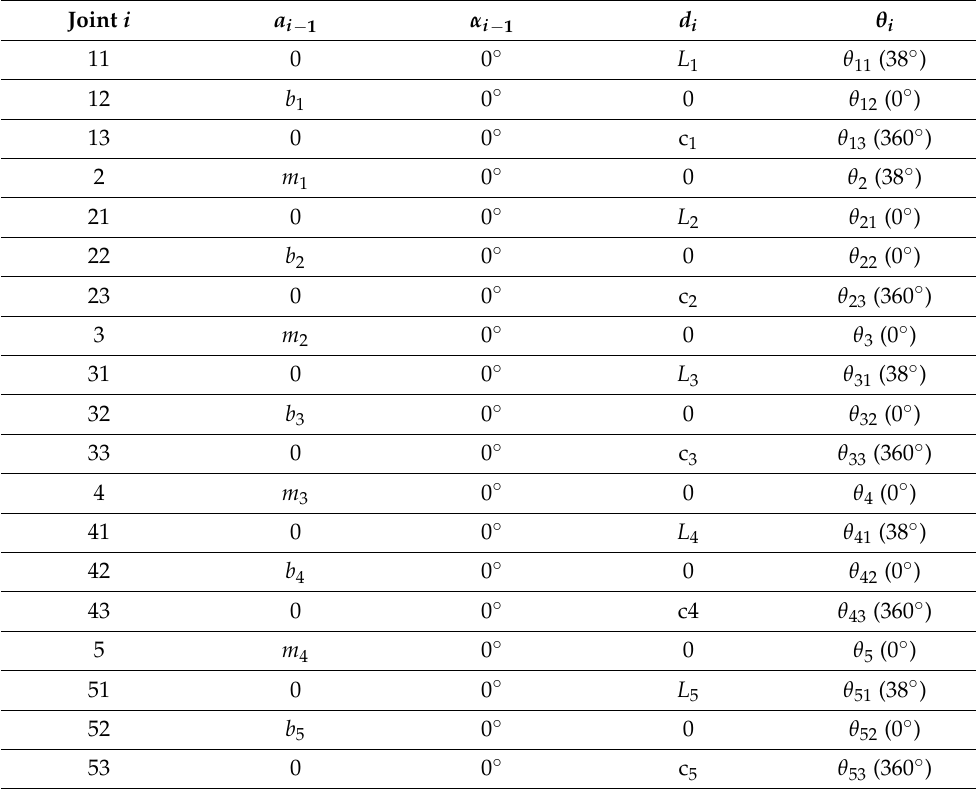
Table 2. D-H coordinate parameters of unilateral torsion bar